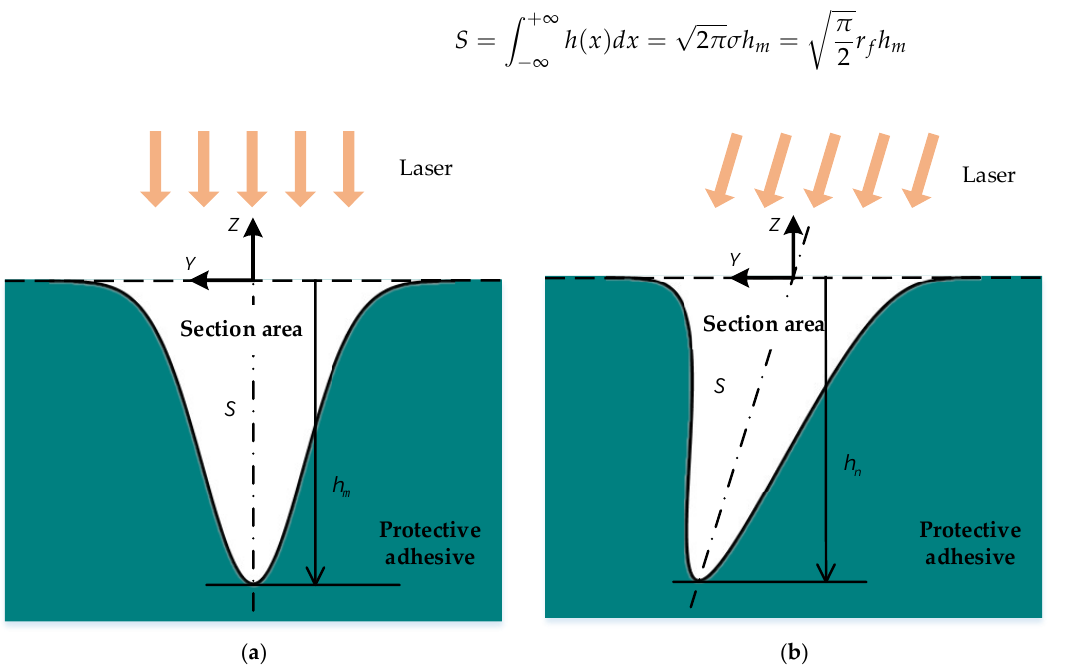
Figure 7. The schematic diagram of 5-axis variable-angle laser engraving.